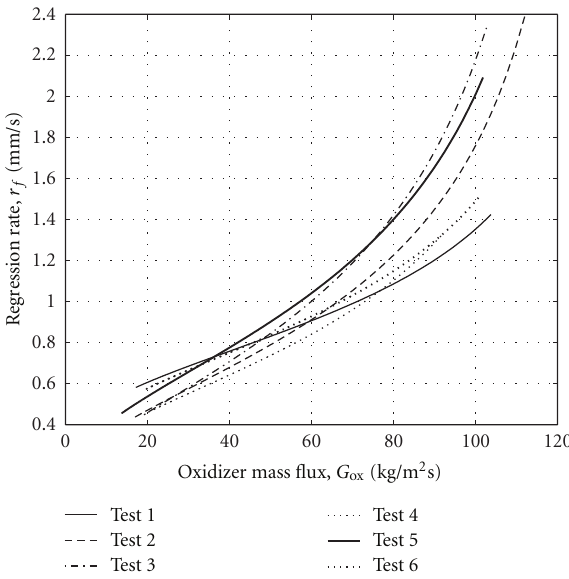
Figure 5: HTPB baseline: regression rate versus oxidizer mass flux for all performed